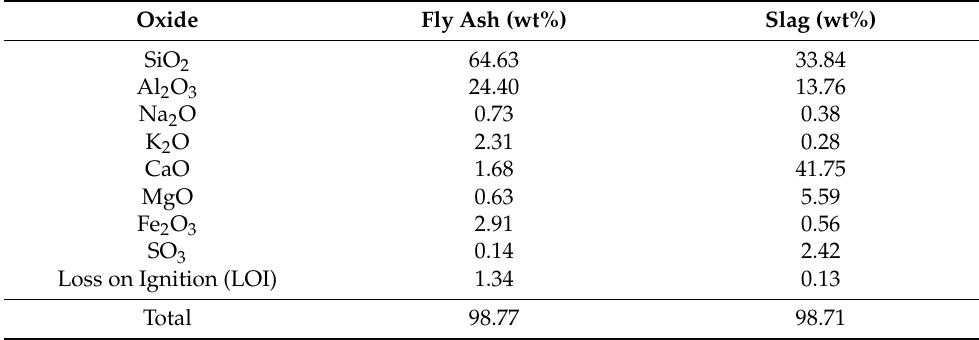
Table 2. Chemical compositions of raw